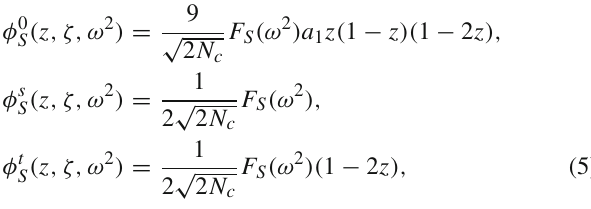
Fig. 1 Feynman diagrams for the B → X R ( → K + K − ) decays with X = J /ψ,η c ,ψ( 2 S ),η c ( 2 S ) at the leading-order approximation. a and b Contributed to the factorizable diagrams, while c and d